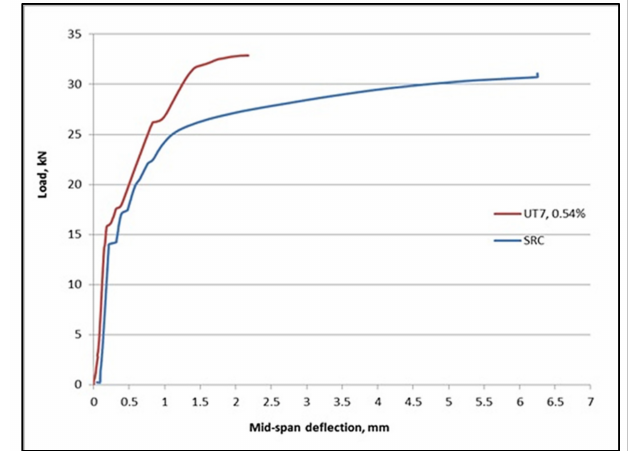
Figure 21. Comparison between mid-span load-deflection uni-axial tow TRC and SRC beams of the same